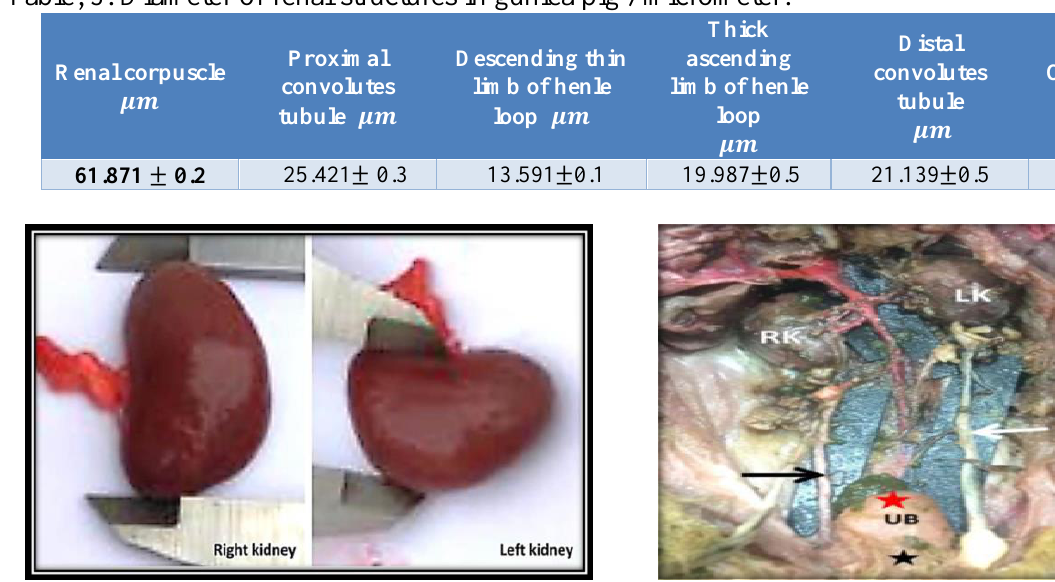
Figure, 1: photograph shows the right and left kidneys of male guinea pig. The right kidney had been shape while left one had heart shape.